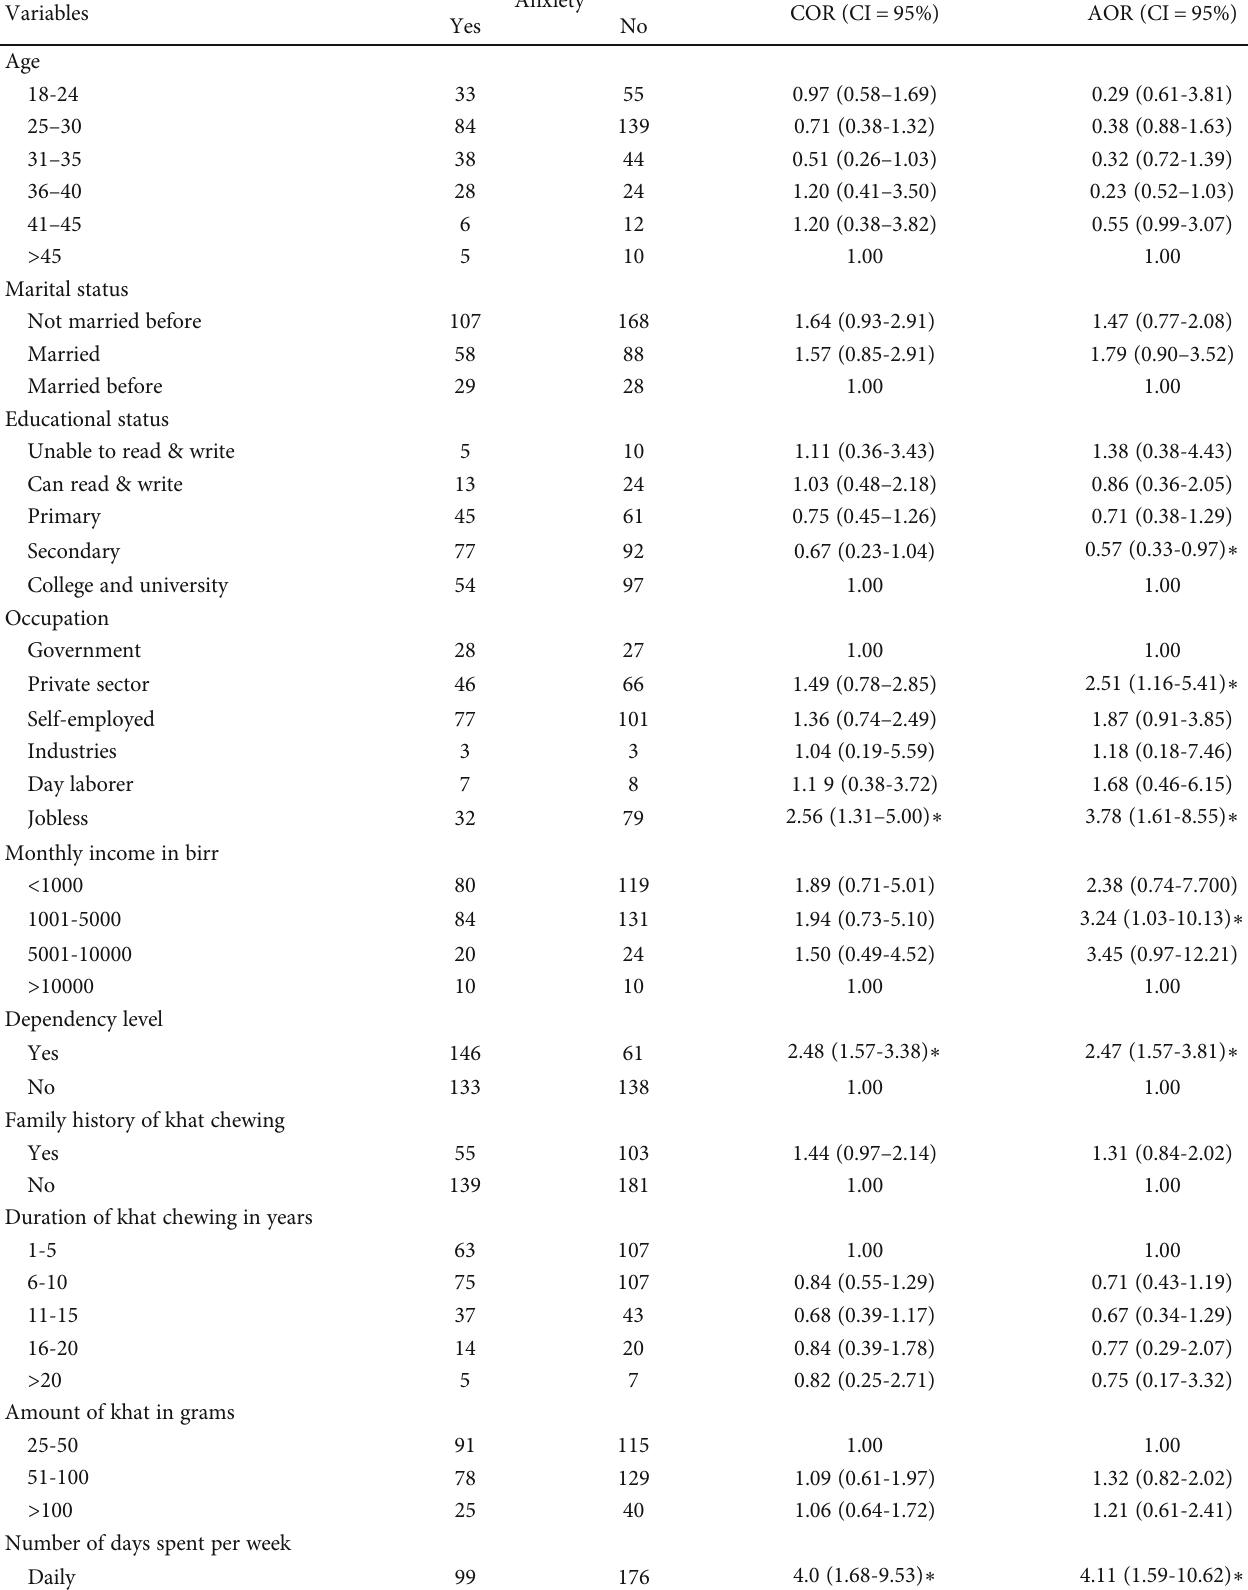
Table 5: Bivariate and multivariate logistic regression factors associated with anxiety among khat chewers in Amhara region, 2019.